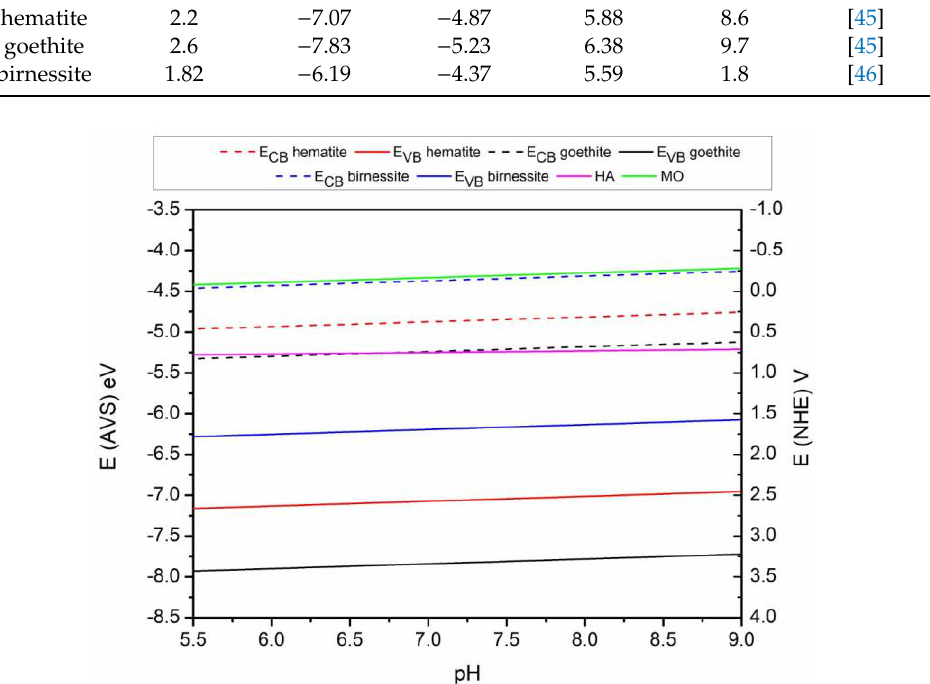
Figure 14. Band edge position of hematite, goethite and birnessite as a function of pH condition. The redox potential of MO and HA (humic acid) [55,56] is above the VB (valence band) position of these minerals, which indicates that MO and HA can serve as photohole scavengers to promote the separation of photoelectrons.